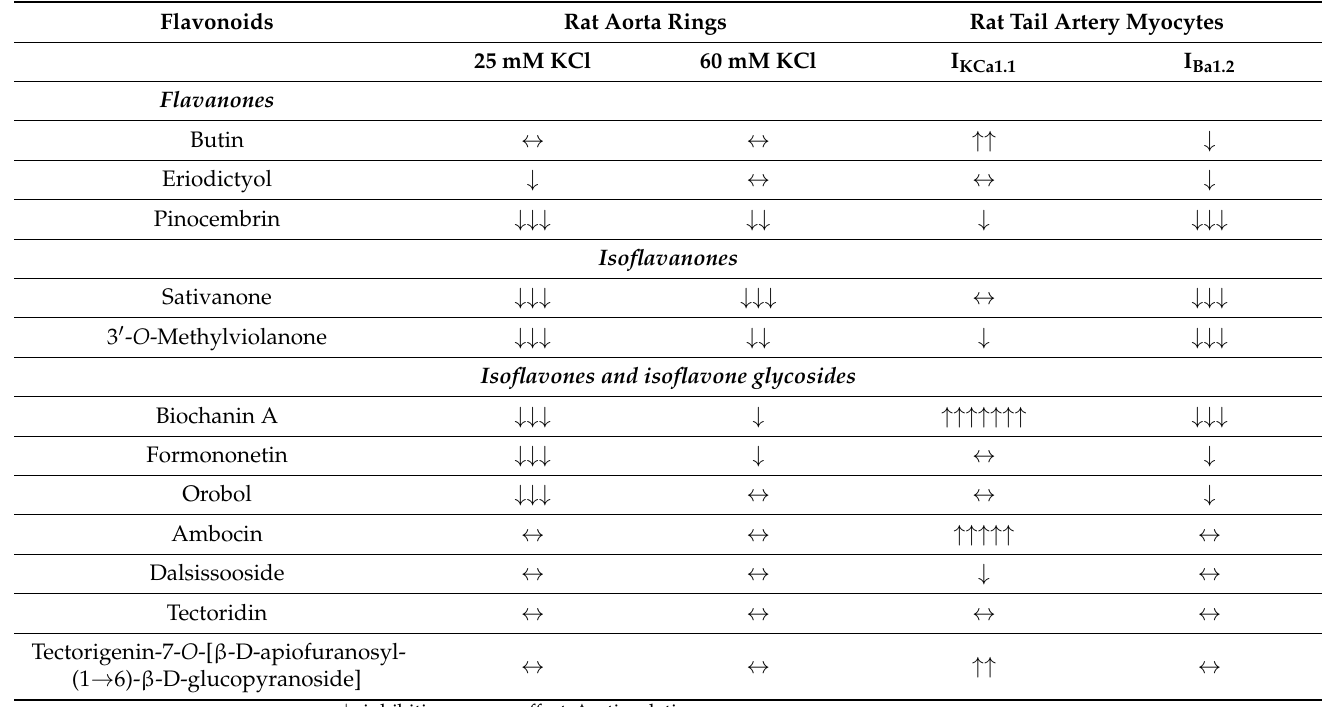
Table 2. Effects of Dalbergia isolates on the different settings analysed.